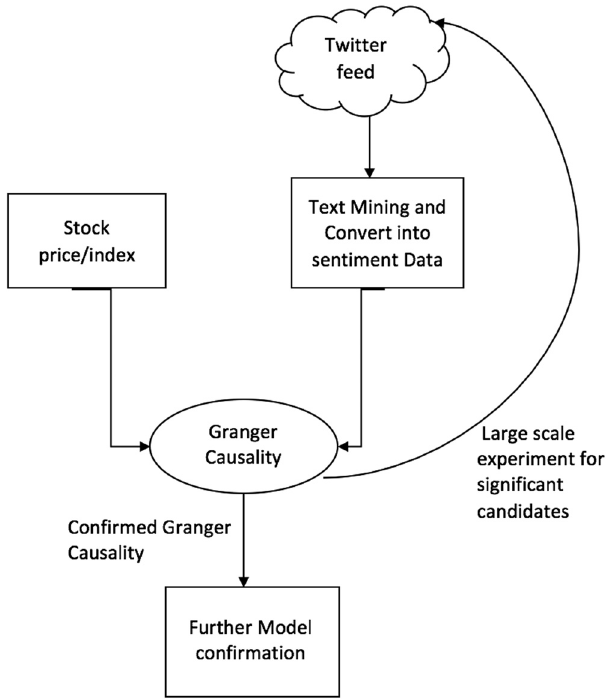
Figure 1: The analysis